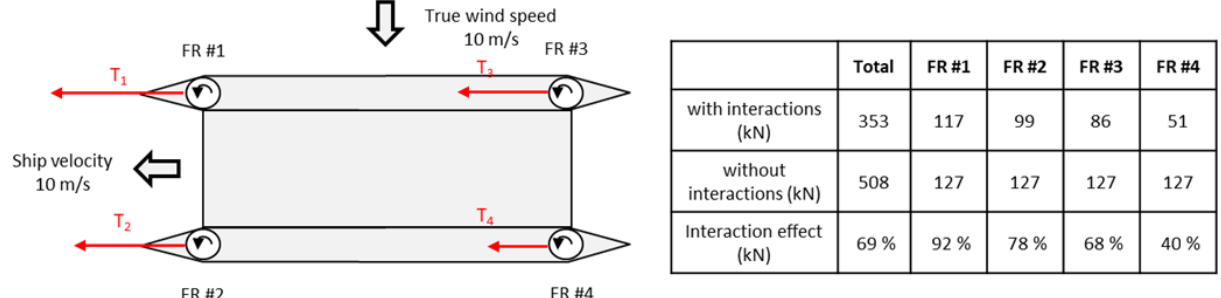
Figure 4. Effect of aerodynamic interactions on the propulsive